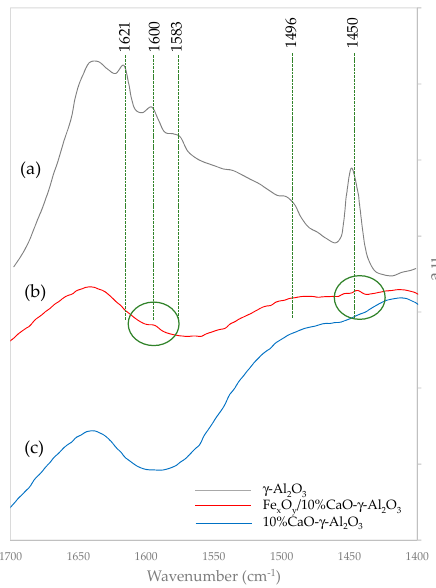
Figure 5. Pyridine FTIR spectra for ( a ) γ -Al 2 O 3 , ( b ) Fe x O y / 10% CaO- γ -Al 2 O 3 , ( c ) 10% CaO- γ -Al 2 O 3 .